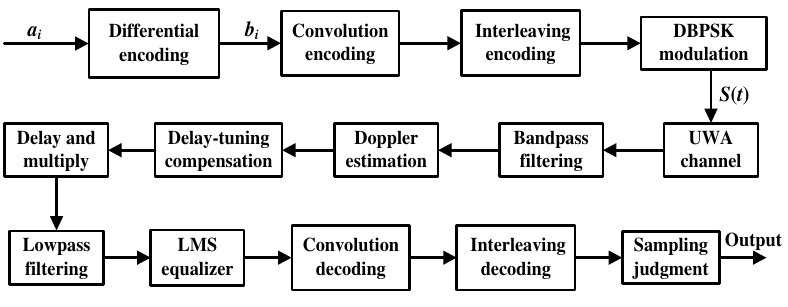
Figure 3. System flow